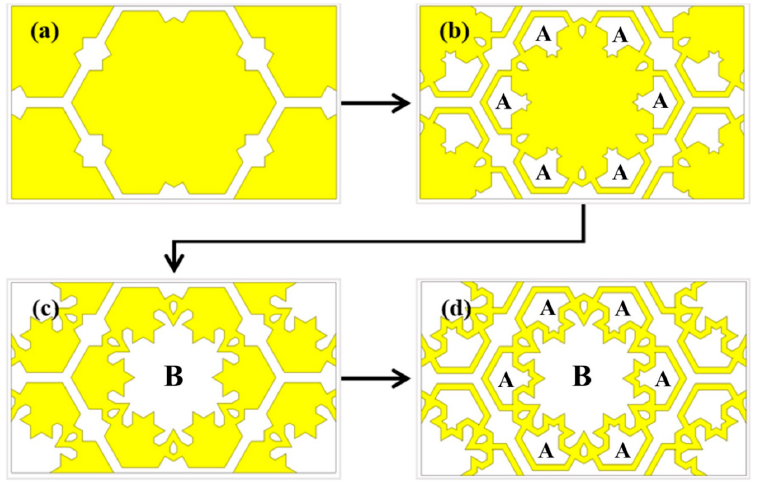
Figure 2. Unit cell evolution of the proposed FSS; ( a ) FSS 1, ( b ) FSS 2, ( c ) FSS 3, and ( d ) MFSS.